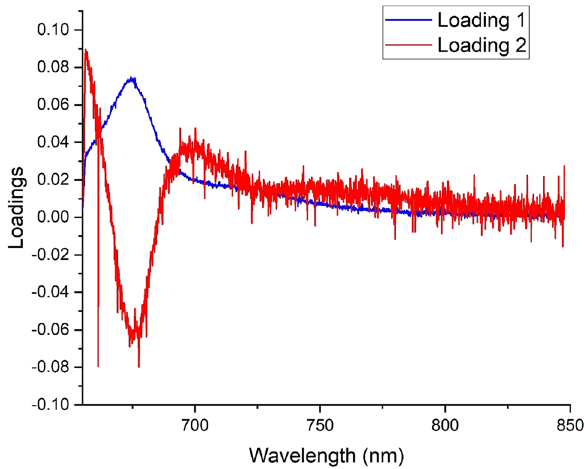
Figure 9. PC1 and PC2 loading plots of 0%, 5% and 10% unripe FFB